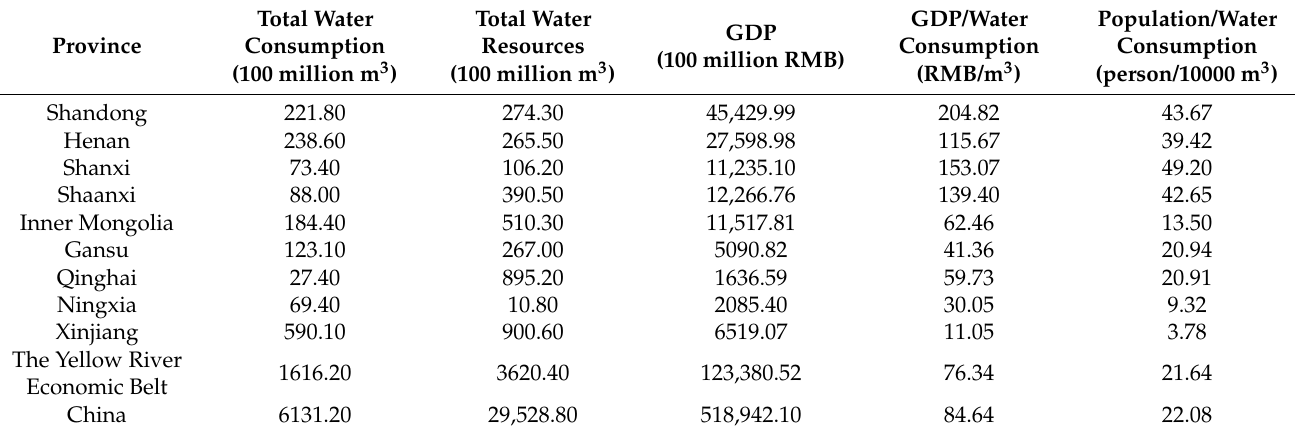
Table 1. Water resources and economic development of the Yellow River Economic Belt (YREB) in 2012.